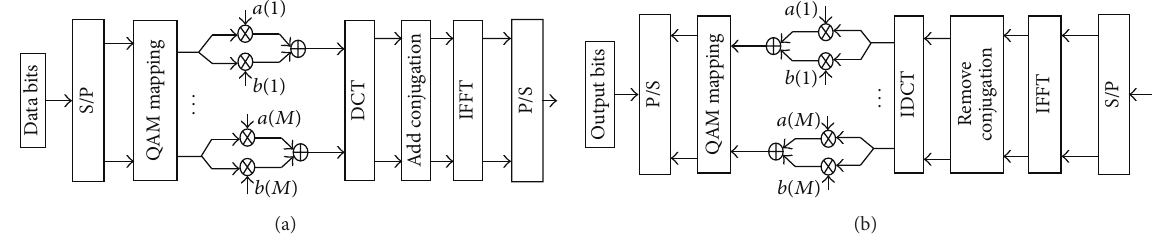
Figure 1: (a) Encryption principle for transmitter. (b) Decryption principle for